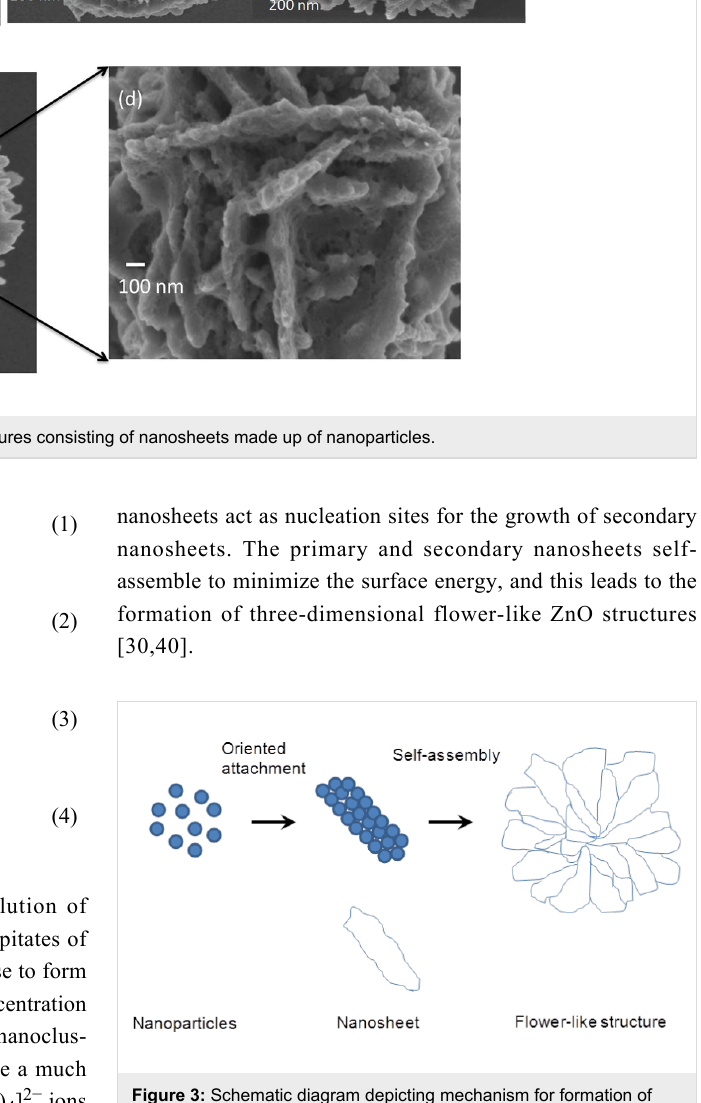
Figure 3: Schematic diagram depicting mechanism for formation of flower-like ZnO structures involving (i) formation of ZnO spherical nanoparticles, (ii) oriented attachment of ZnO nanoparticles resulting in nanosheets, followed by (iii) self-assembly of nanosheets into flower- like ZnO